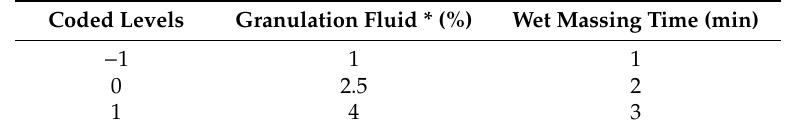
Table 8. The levels of independent process variables used in design of experiment.